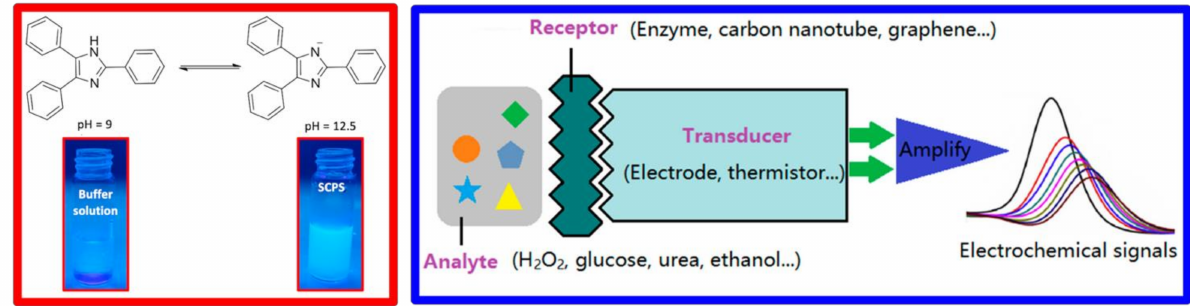
Figure 4. Chemical sensors and respective mechanisms. Right side show the fluorescence of the samples irradiated under 365 nm. Left side show the signal obtained